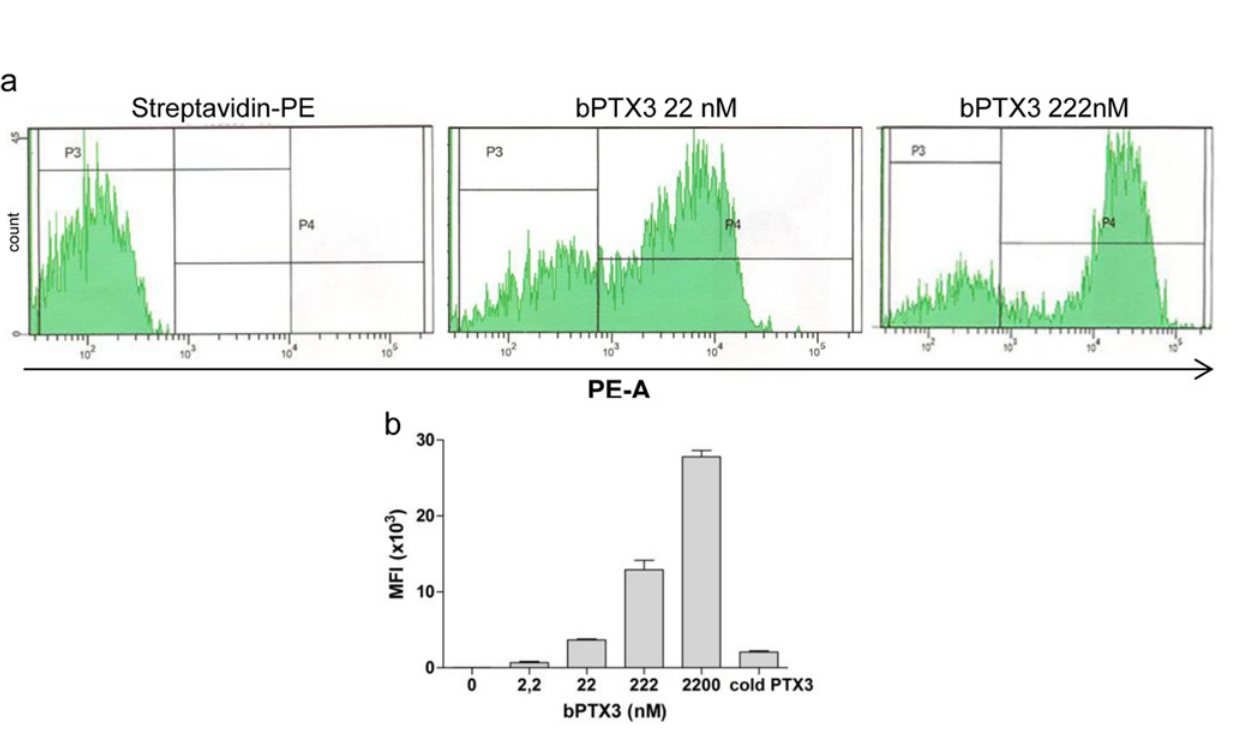
and 222 nM respectively). Given the homology between PTX3 and the prototypic short pen-